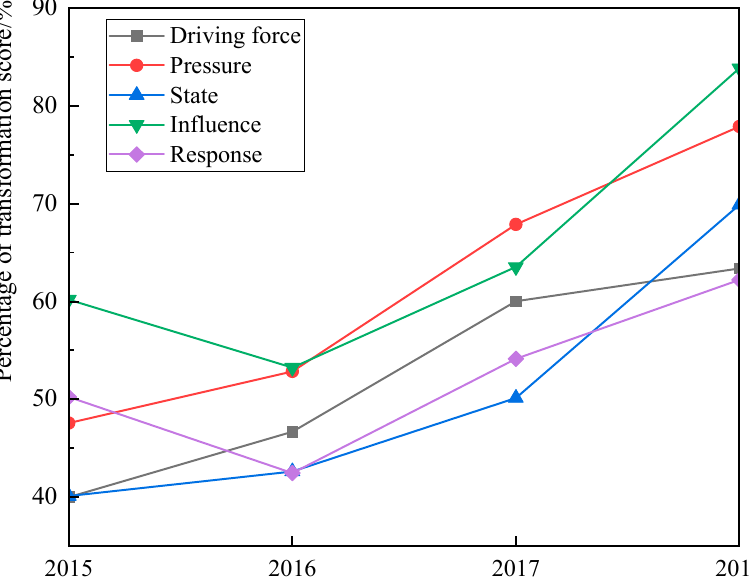
Figure 8. Scoring percentage of subsystems in social and economic transformation of coal-based energy cities.